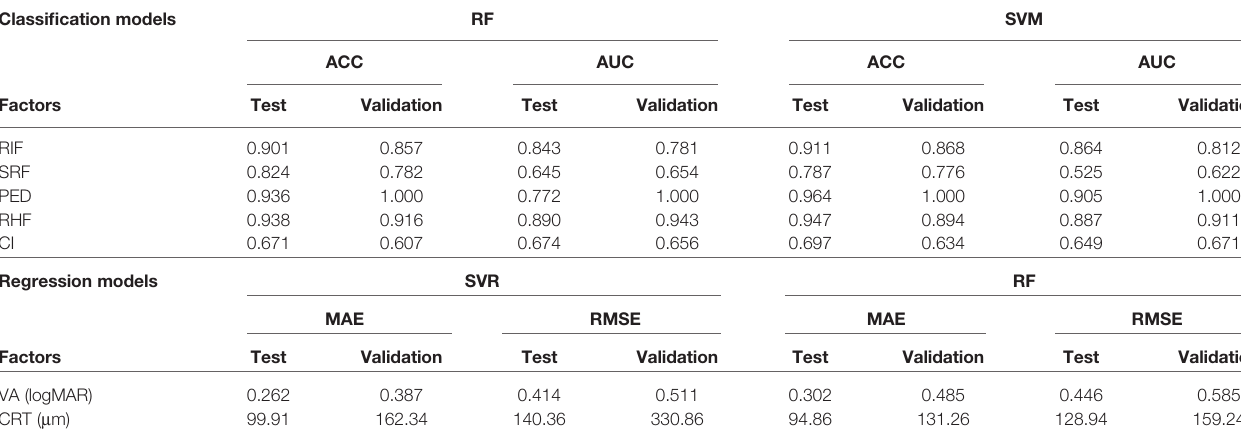
TABLE 2 | The prediction performances of the best two models in classi fi cation and regression tasks. Classi fi cation models